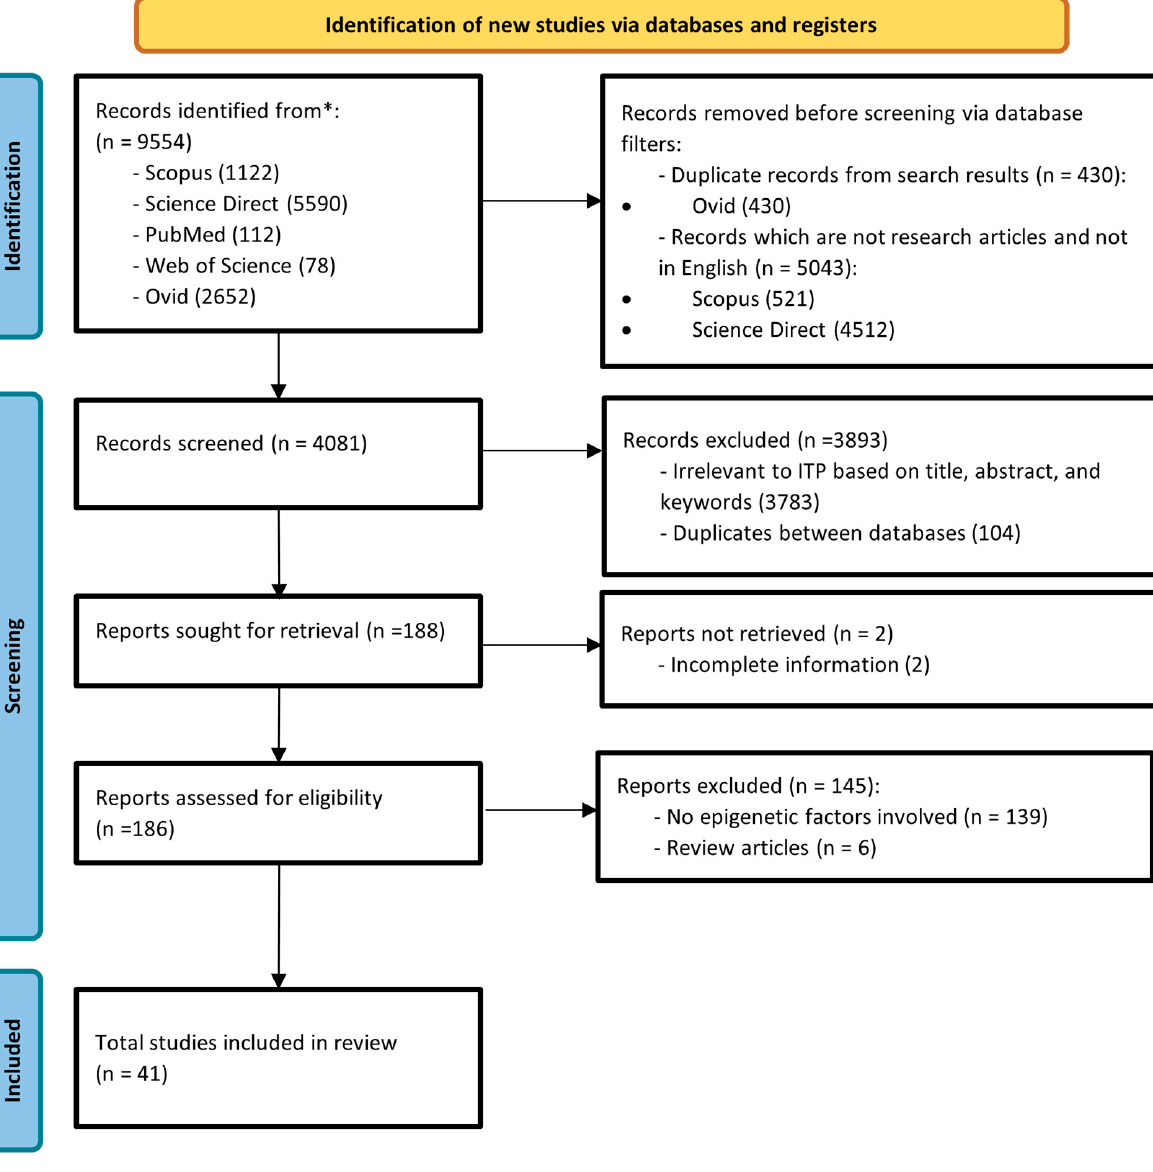
Figure 1. Flowchart of record identification related to epigenetic mechanisms in immune thrombo ‐ cytopenia purpura (ITP). *databases of Scopus, Science Direct, PubMed, Web of Science and Ovid.